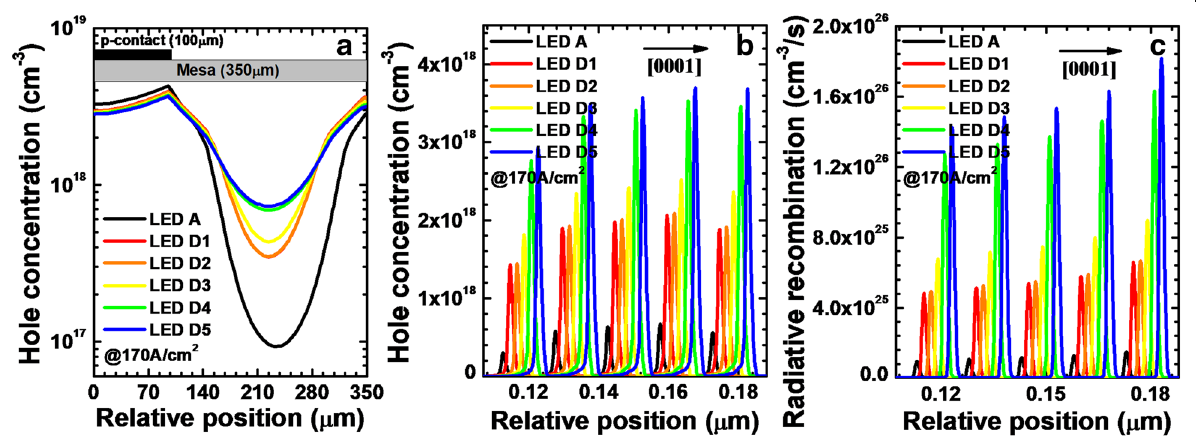
Fig. 9 a Horizontal hole concentration in the LQW, b hole concentration levels, and c radiative recombination profiles in the MQWs for LEDs A and D i ( i = 1, 2, 3, 4, and 5) when the current density is 170 A/cm 2 . We purposely shift the curves for b and c by 2 nm for easier identification